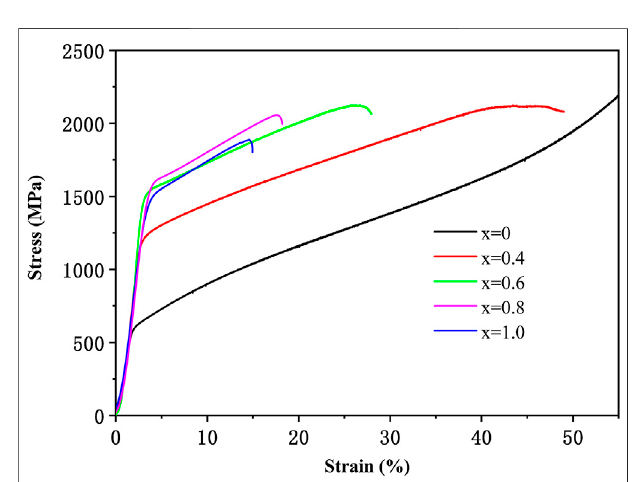
FIGURE 8 | Compressive engineering stress-strain curves of the bulk FeCoNi(CuAl) x MEA and